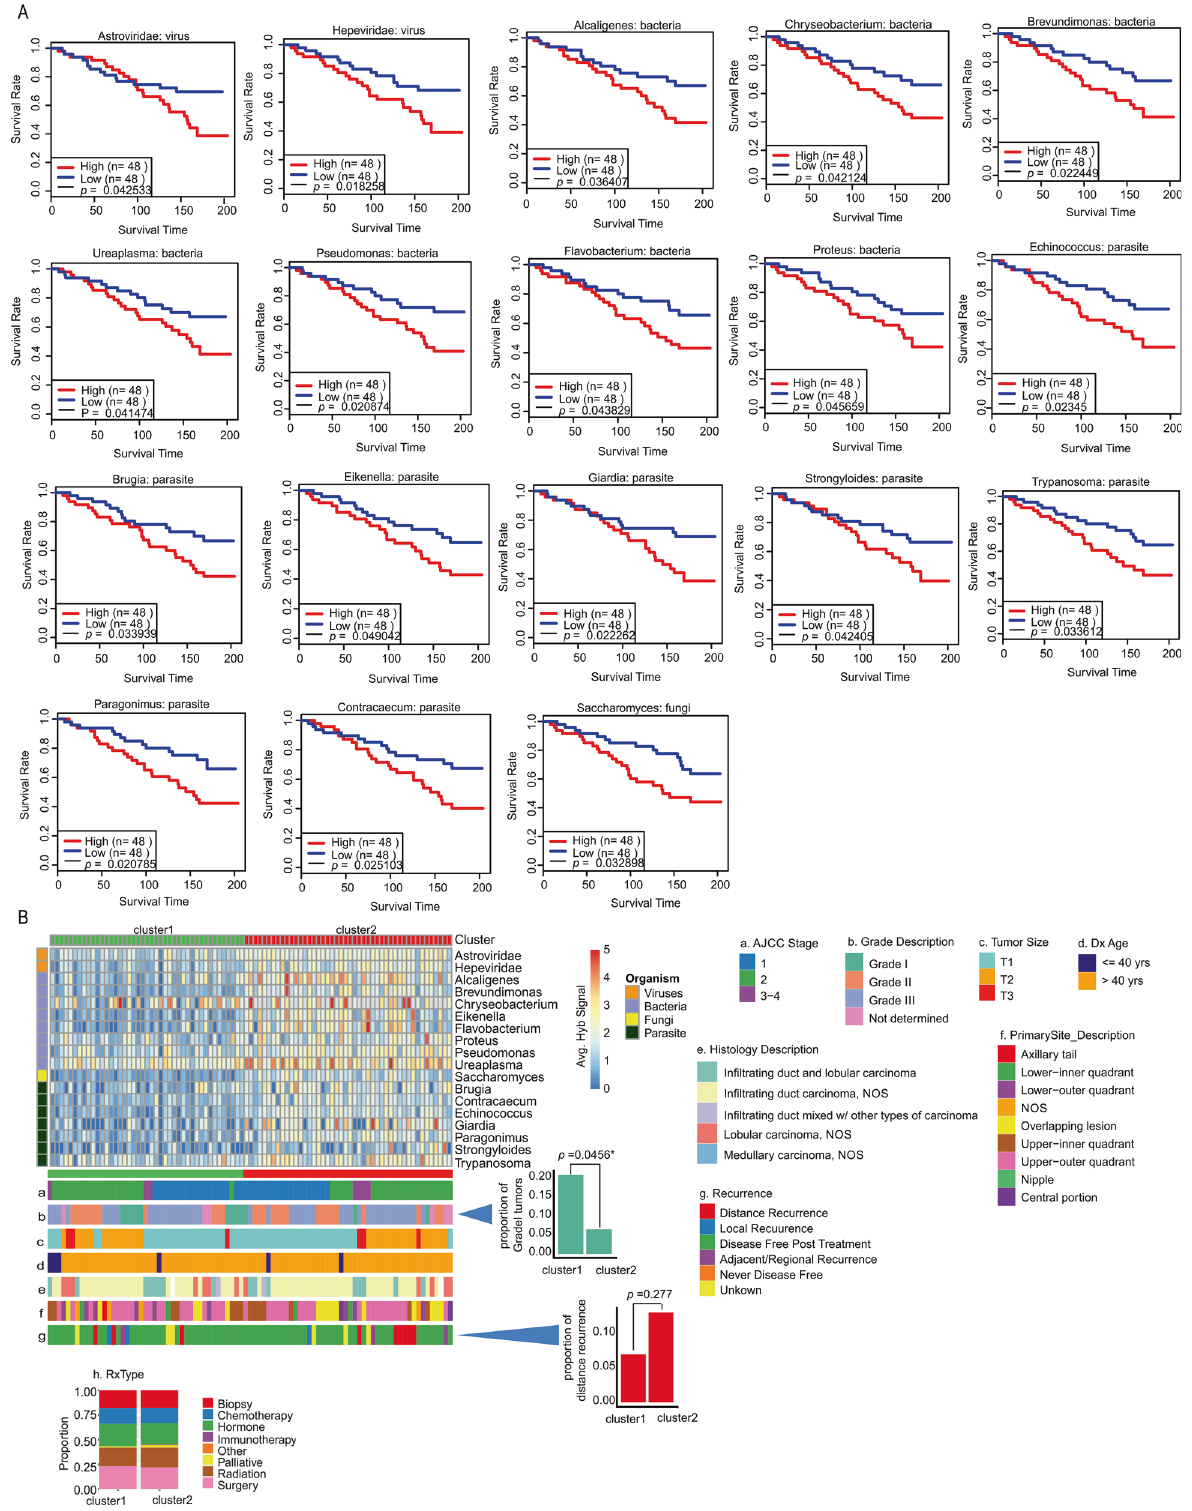
Fig. 6 Oncobiome signatures in ER + BCs where high hybridization signals correlated with worse disease outcome. A The graphs show survival time relative to high or low hybridization signals for the speci fi c microorganisms shown. In the cases shown, higher hybridization signal correlated with decreased survival. B . ER + BC samples were then clustered based on the hybridization levels for these microorganisms. The low (cluster 1) and the high (cluster 2) hybridization detection clusters correlated with other clinical data shown as horizontal ( a – g ) and vertical ( h ) cluster